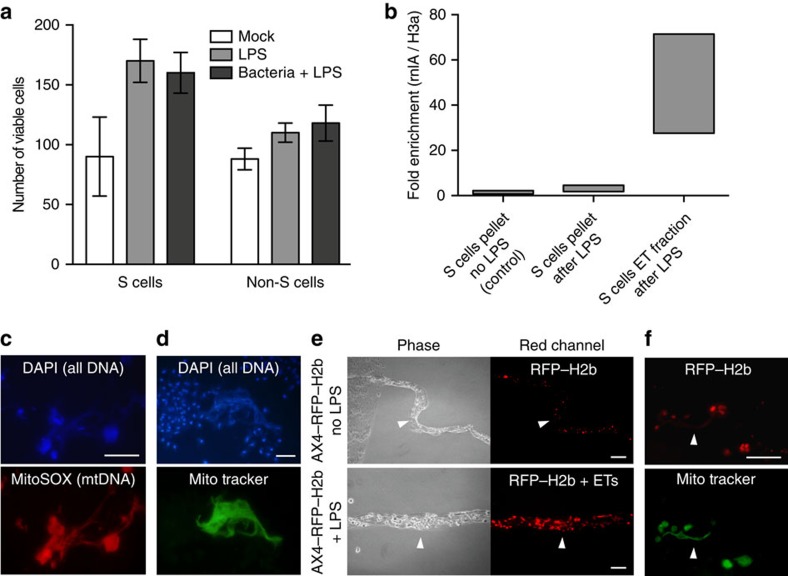
ETs are mainly composed of mitochondrial DNA.(a) The viability of purified S and non-S cells was not impaired after exposure to LPS or the combination of LPS and K.p., n=3. (b) AX4 slugs developed from cells initially grown in axenic conditions were treated with LPS for ET stimulation followed by qPCR analysis. A representative result from three independent experiments performed in triplicates is shown. The range of relative folds of enrichment of mtDNA versus nuclear DNA compared with the control was calculated by the ΔΔCt method. (c,d) Visualization of ETs produced from disaggregated AX4 slug cells with MitoSox Red and MitoTracker Green staining after LPS stimulation (see Methods section ‘Visualization of ETs' for experimental details). The total DNA was visualized by DAPI staining after fixation. (e) Comparison of S cell-containing trails (arrowheads) left behind migrating slugs of AX4–RFP–H2b strain on PI-containing agar plates in the absence or presence of LPS. (f) ETs (arrowheads) produced by S cells from AX4–RFP–H2b slugs on LPS stimulation are positive for preloaded MitoTracker Green, but not for RFP–H2b. Error bars: s.e.m. Scale bars, (e) 100 μm; the rest 20 μm. qPCR, quantitative PCR.